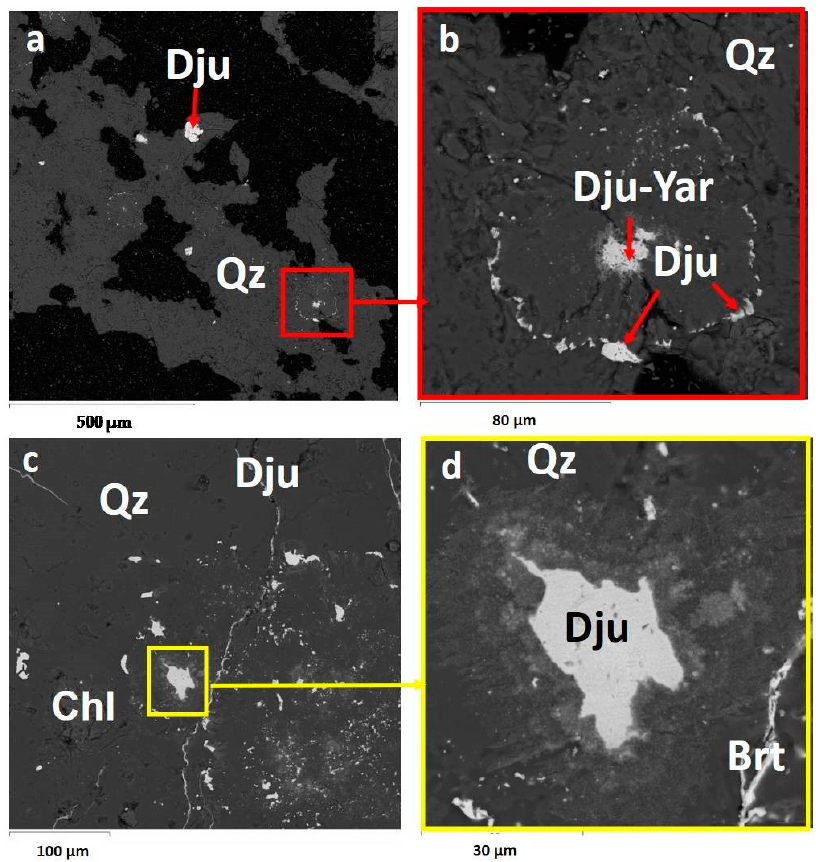
Figure 13. SE micrographs of fragments of agate No. 5 (Figure 4d) with inclusions of copper sulphides: ( a , b ) djurleite-anilite-yarrowite (Dju-Yar) were present in the interstices of fine-grained spherulite aggregate of quartz; ( c , d ) djurleite (Dju) and barite (Brt) micro veins were present in the quartz or quartz-chlorite (Chl) aggregate.